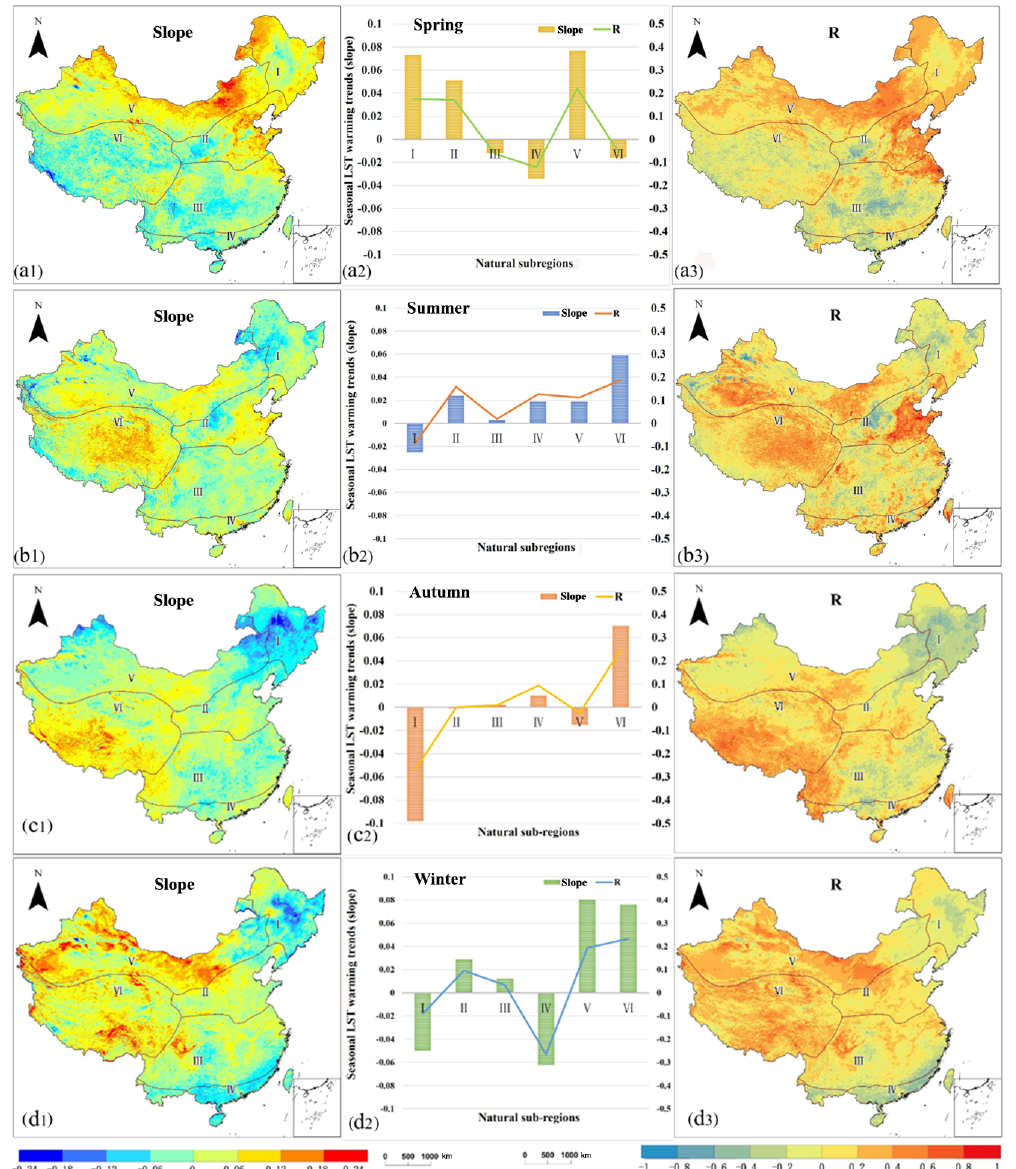
Figure B1. The interseasonal variability rates (slope) and correlation coefficients ( R ) of LST in spring (a) , summer (b) , autumn (c) and winter (d) from 2003 to 2017: (a1) , (b1) , (c1) and (d1) are the spatial distributions of the slopes in the four seasons; (a2) , (b2) , (c2) and (d2) are histograms of the slopes in the four seasons; and (a3) , (b3) , (c3) and (d3) are the spatial distributions of the correlation coefficients ( R ) in the four